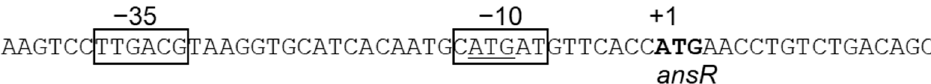
Figure 3. The promoter region of the ans operon. The transcriptional start site is indicated with +1. The initiation codon of ansR is shown in bold letters. The incorrect initiation codon previously deposited is indicated with an underline. The − 35 and − 10 regions of the σ A -dependent promoter are indicated using boxes.